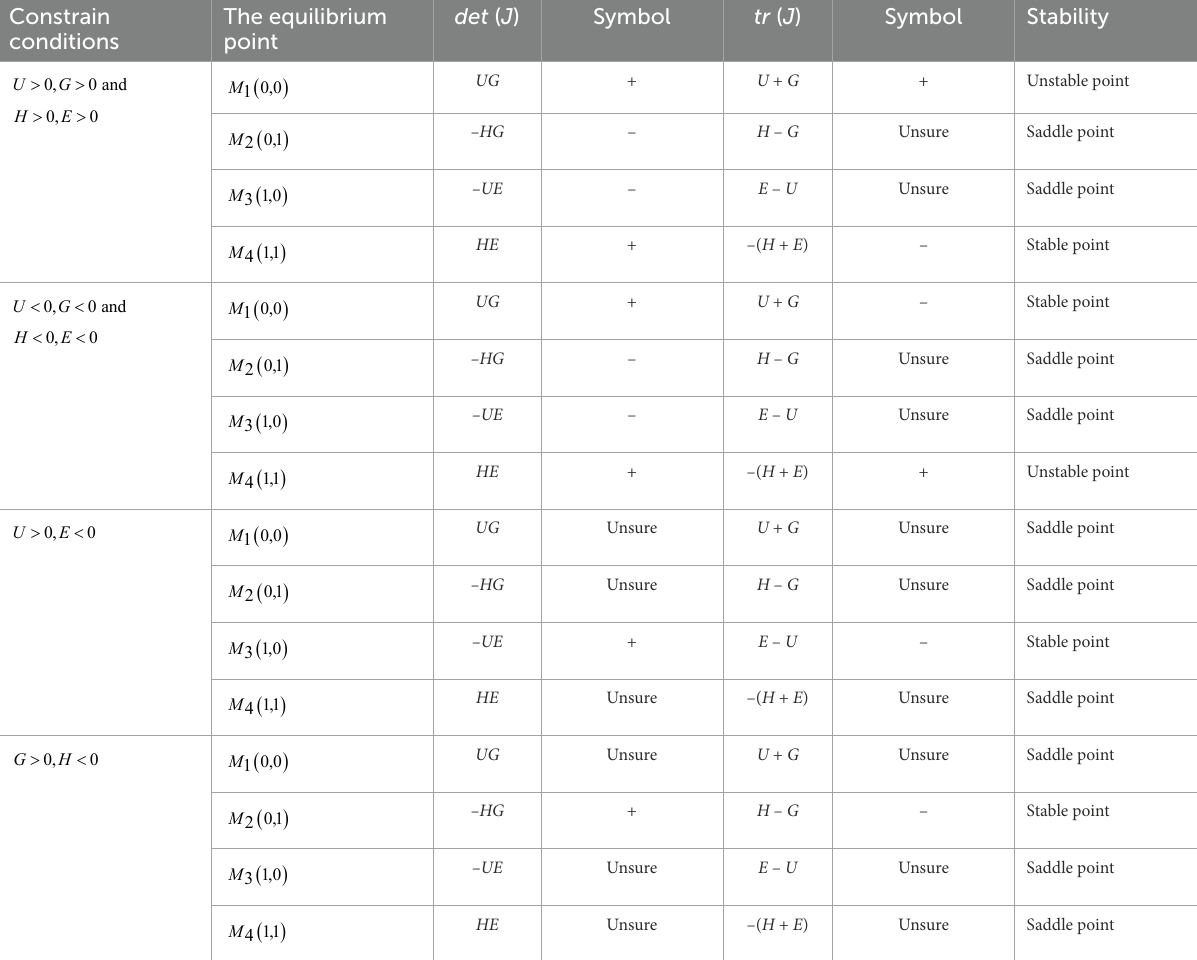
TABLE 4 The stability analysis of the equilibrium